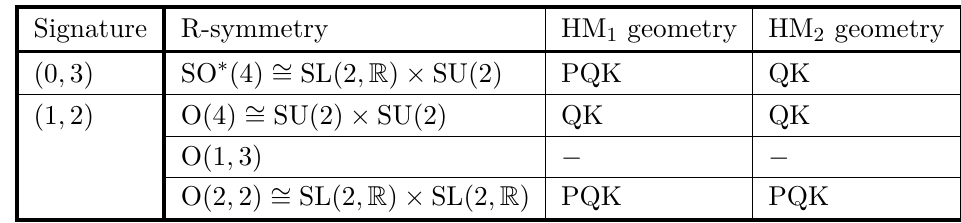
Table 14. Three-dimensional N = 4 supersymmetry algebras, their R-symmetry groups and the scalar geometries of the two hypermultiplet